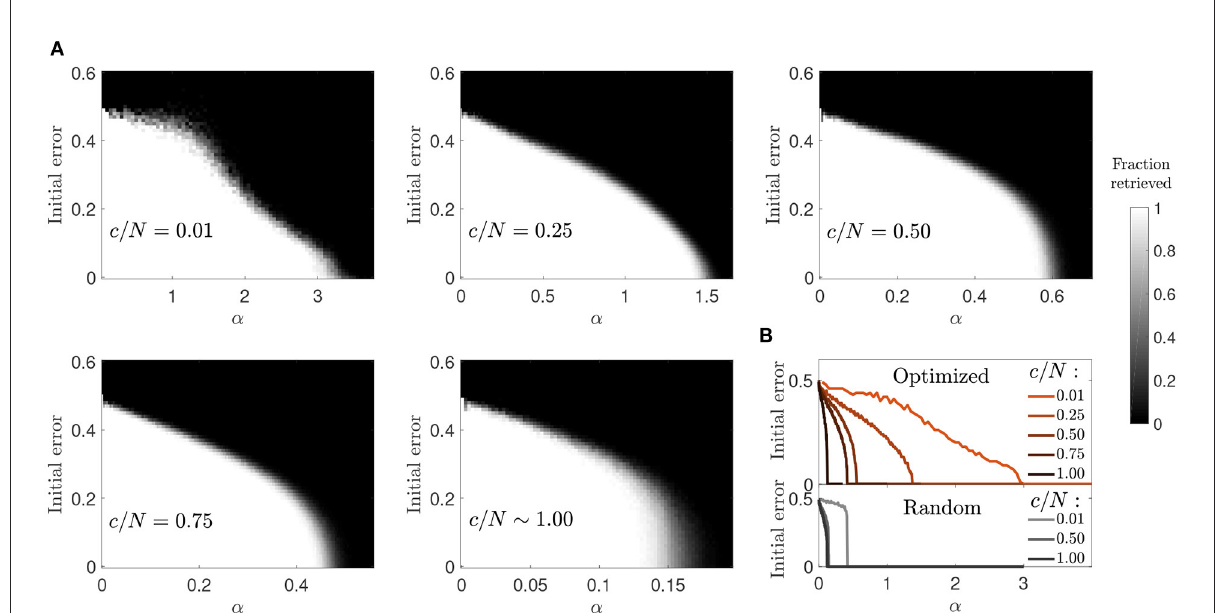
FIGURE9 Enhanced basins of attraction in networks optimized by signal reinforcement. (A) Fraction of patterns (gray-scale) a network of N = 2,000 can successfully retrieve, after initializing it in each of the α · c stored patterns with a given initial error. (B) Condenses shown information for each connectivity (color coded) by plotting the maximum initial error tolerance for which the network can successfully retrieve all patterns for each α value (optimized networks, top; random networks, bottom).